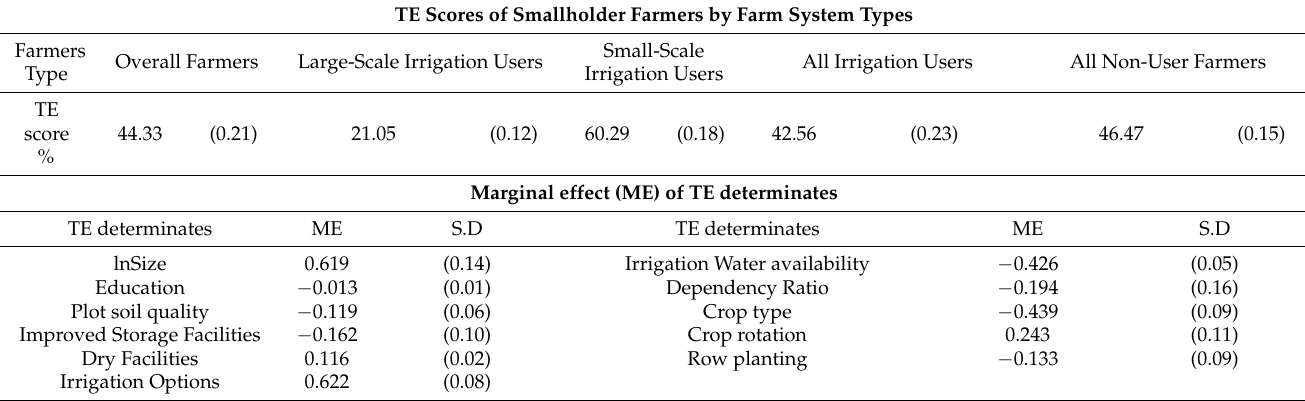
Table 6. TE scores and marginal effects of inefficiency